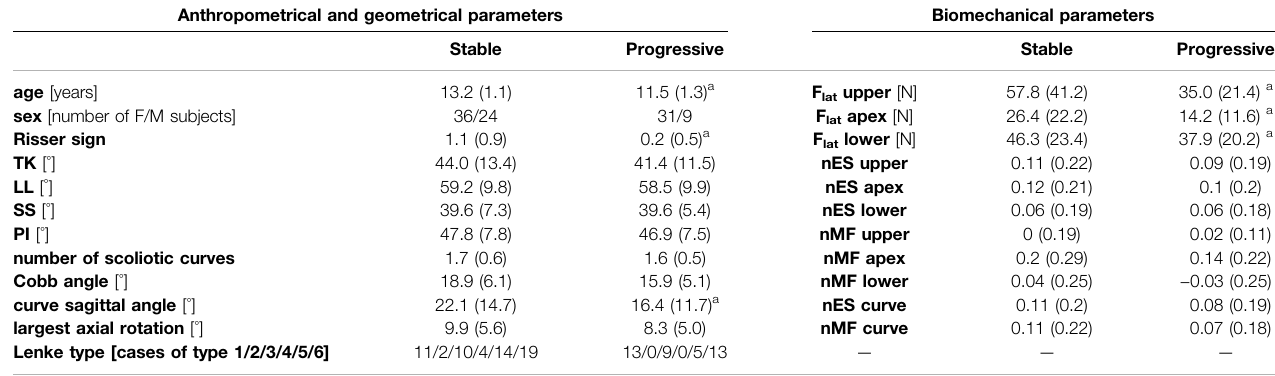
TABLE 2 | values of anthropometrical and geometrical parameters, and of biomechanical parameters, expressed as mean (SD) or number of cases, for stable and progressive subjects. Anthropometrical and geometrical parameters Biomechanical parameters